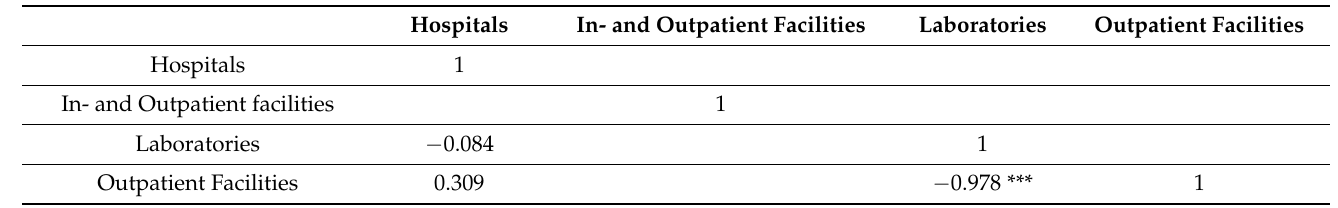
Table 4. Correlation matrix, Eastern Mediterranean.